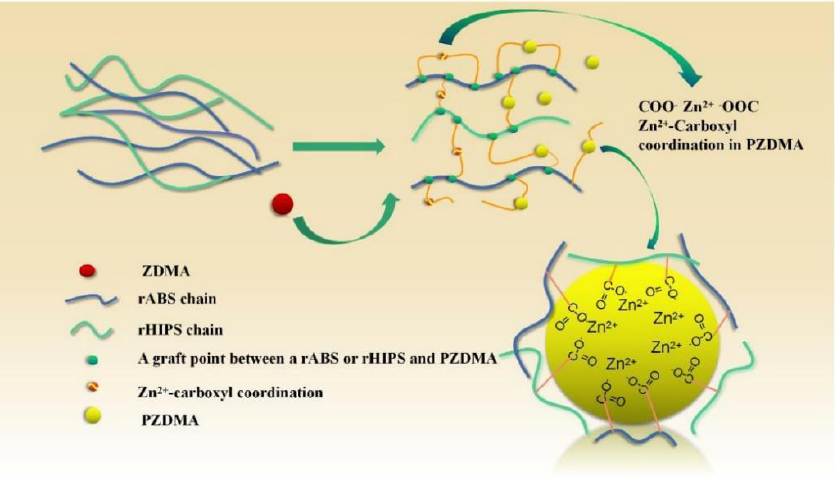
Figure 40. Mechanism of ionic cross-linking in recycled PS blends. Reprinted with permission from ref. [112]. ref.